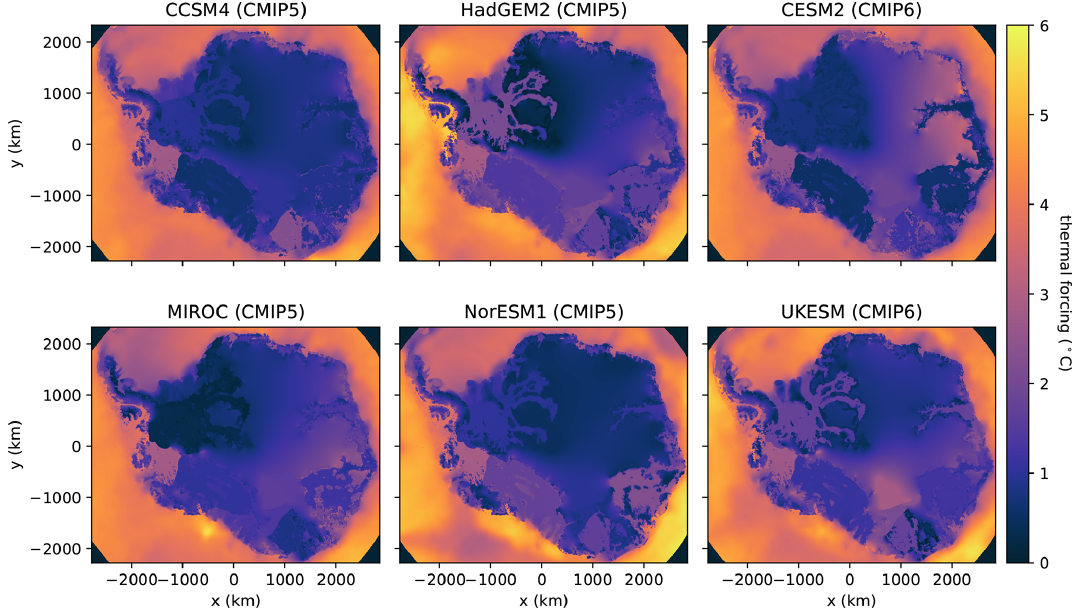
Figure 9. Ocean thermal forcing ( ◦ C) at z = − 510m, averaged over 2081–2100, for the four CMIP5 models and two CMIP6 models used in ocean-forced projection experiments. Thermal forcing is used to compute basal melt rates in grid cells with floating ice.